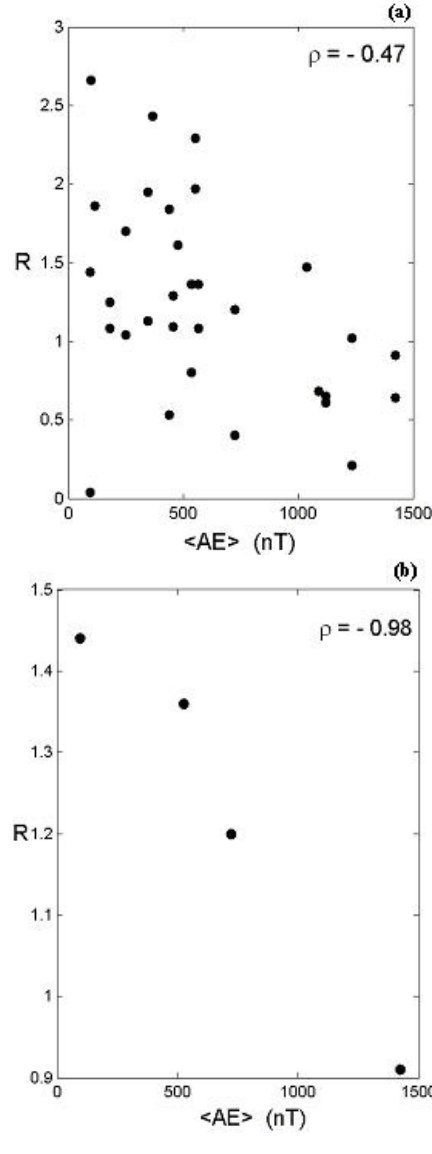
Fig. 6 Fig. 6 Fig. 6. The R -values plotted as a function of the AE index averaged over 1h preceding the storm onset: ( a ) all the intervals, ( b ) only afternoon intervals during E y > 8mV/m